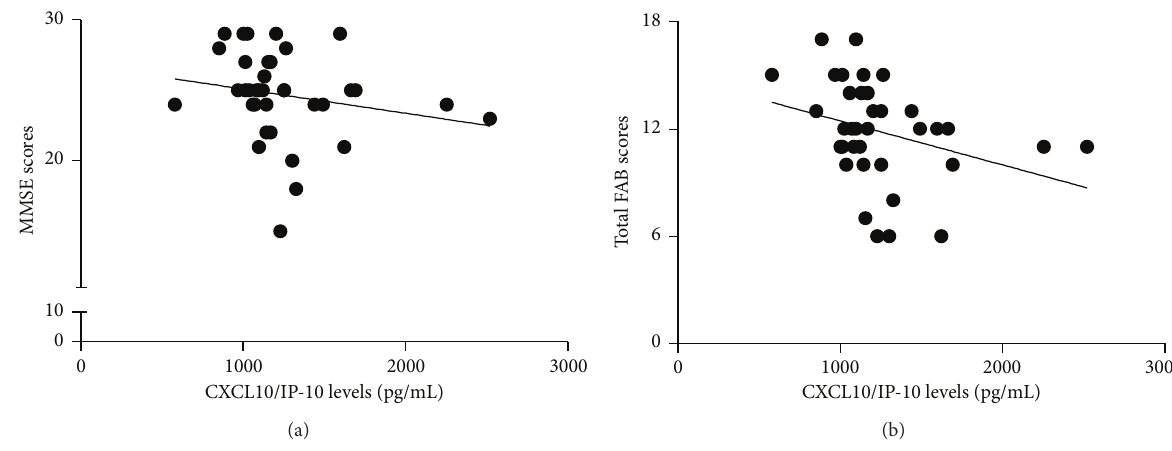
Figure 2: Among Parkinson’s disease (PD) patients, plasma levels of CXCL10/IP-10 were inversely associated with MMSE (a; 𝜌 = − 0.395, 𝑃 = 0.016 ) and total FAB scores (b; 𝜌 = − 0.458, 𝑃 = 0.004 ). IP-10: interferon gamma-induced protein-10; MMSE: Mini-Mental State Examination; FAB: Frontal Assessment